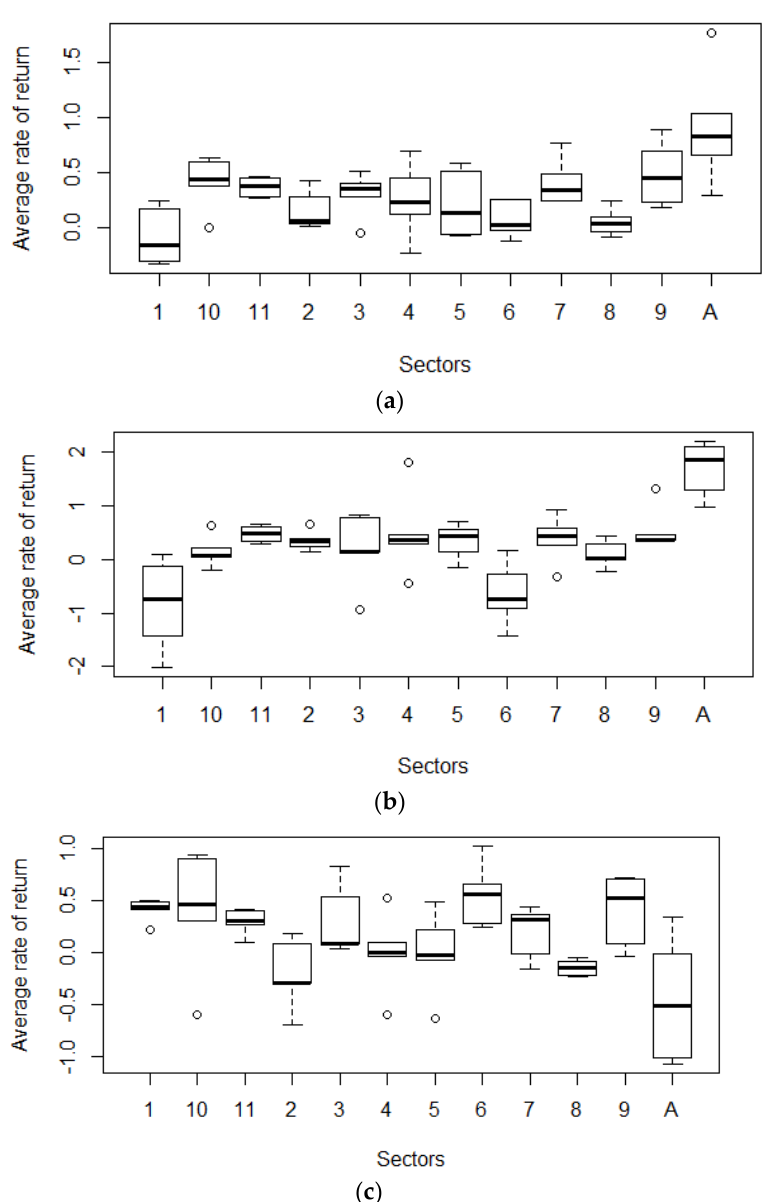
Figure 2. Average weekly rates of return for alternative energy and main stock market sectors: ( a ) 2021. Source: Authors’ own calculations and elaborations based on Refinitiv Datastream.